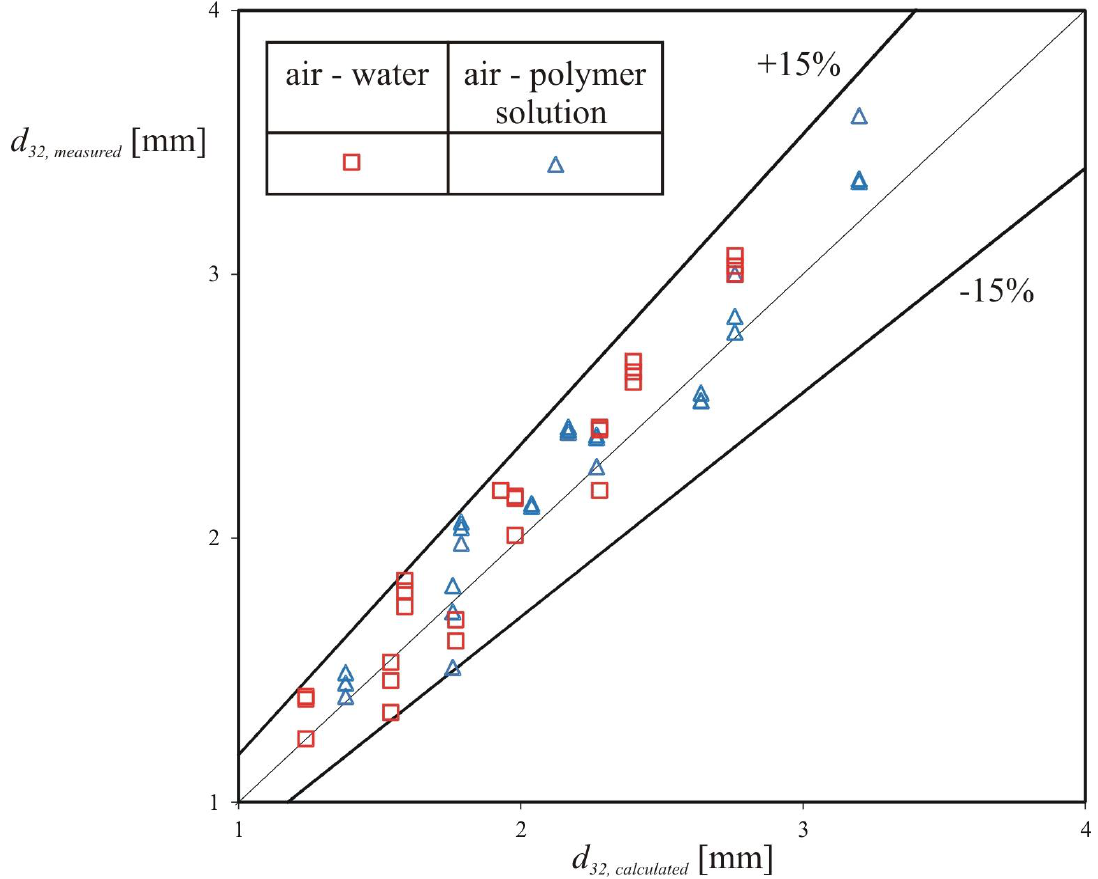
Figure 7. Comparison of measured drop size with calculated drop size from Equation (9).